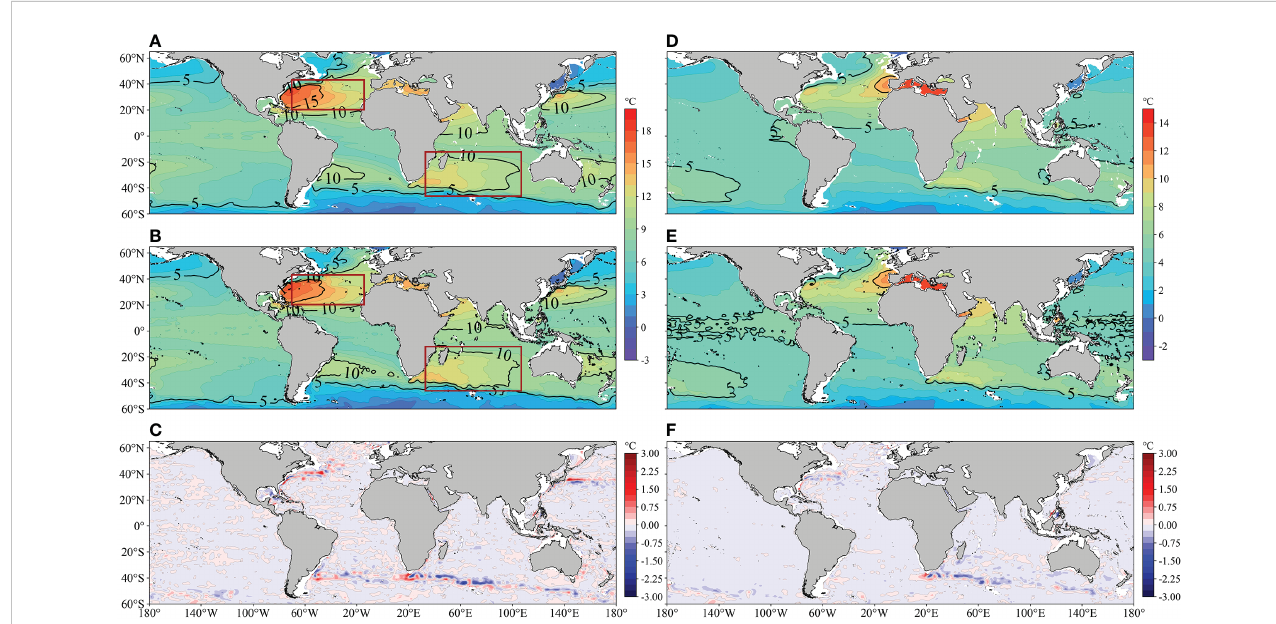
FIGURE 9 Global climatic (1995~2017) 500m sea temperature distribution of (A) ODF-ST dataset, (B) WOA18, and (C) their difference; Global climatic (1995~2017) 900m sea temperature distribution of (D) ODF-ST dataset, (E) WOA18, and (F) their difference.